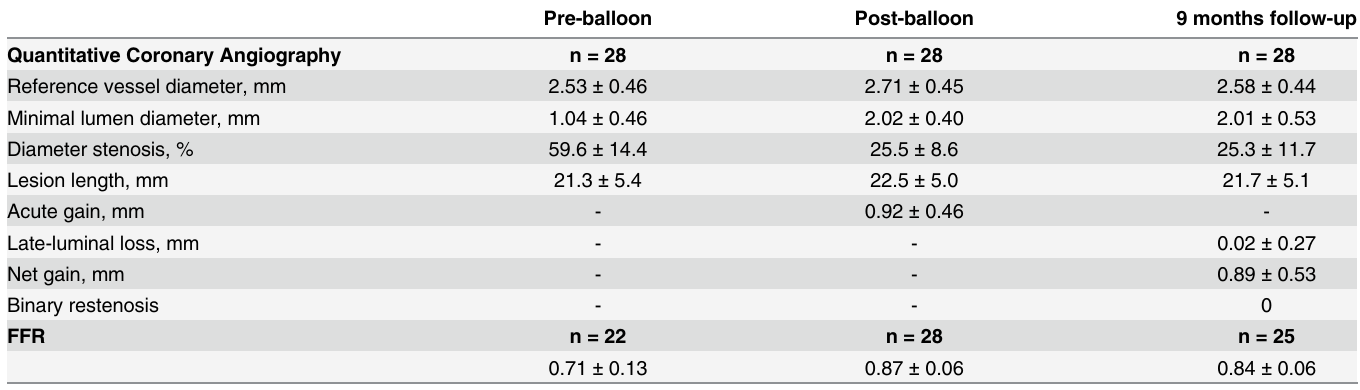
Table 3. Quantitative coronary angiography and functional